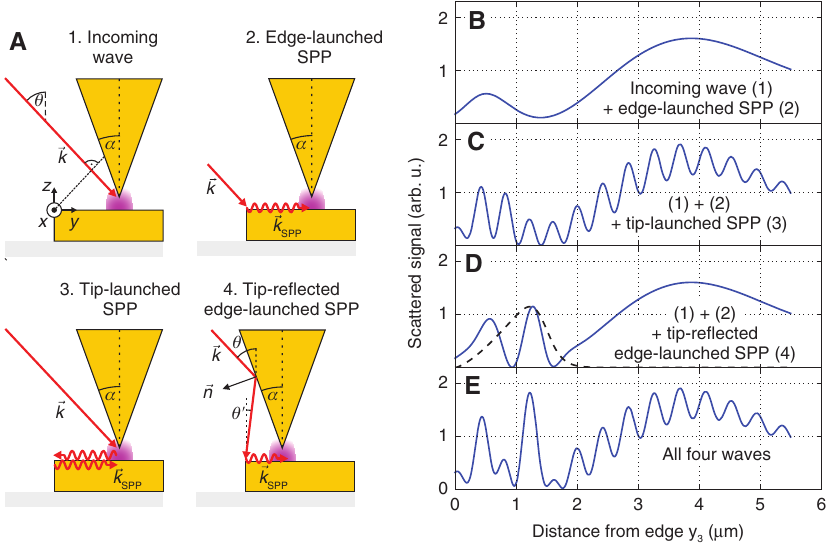
Figure 2: Numerical simulation of the s-SNOM signal along line 3 in Figure 1. (A) Sketch of four coherent s-SNOM signal contributions: (1) incoming beam; (2) SPP generated at the metal edge; (3) SPP launched at the s-SNOM tip, propagating to the edge of the metal film, reflected there and returning to the tip; (4) incoming beam reflected from the tip shaft onto the metal edge, generating an SPP there that propagates to the tip. (B–E) Calculated s-SNOM signals (time-averaged absolute square of the sum of the fields) at the location of the tip a distance y from the metal edge for various combinations of the four signal 3